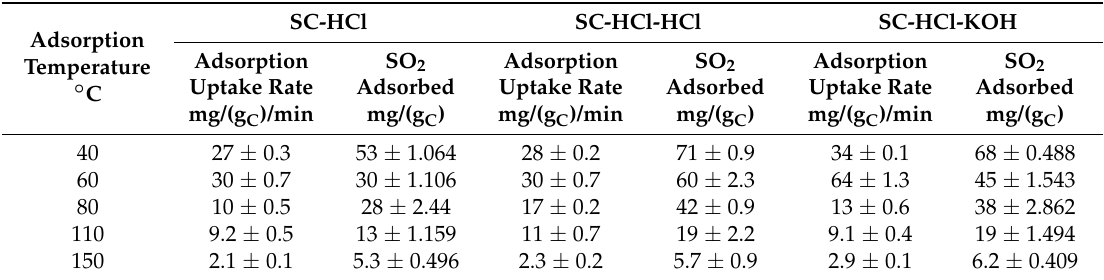
Table 2. Initial fast adsorption rates for SO 2 capture on activated semi-cokes ( ± 1 standard deviation). Adsorption Temperature ◦ C